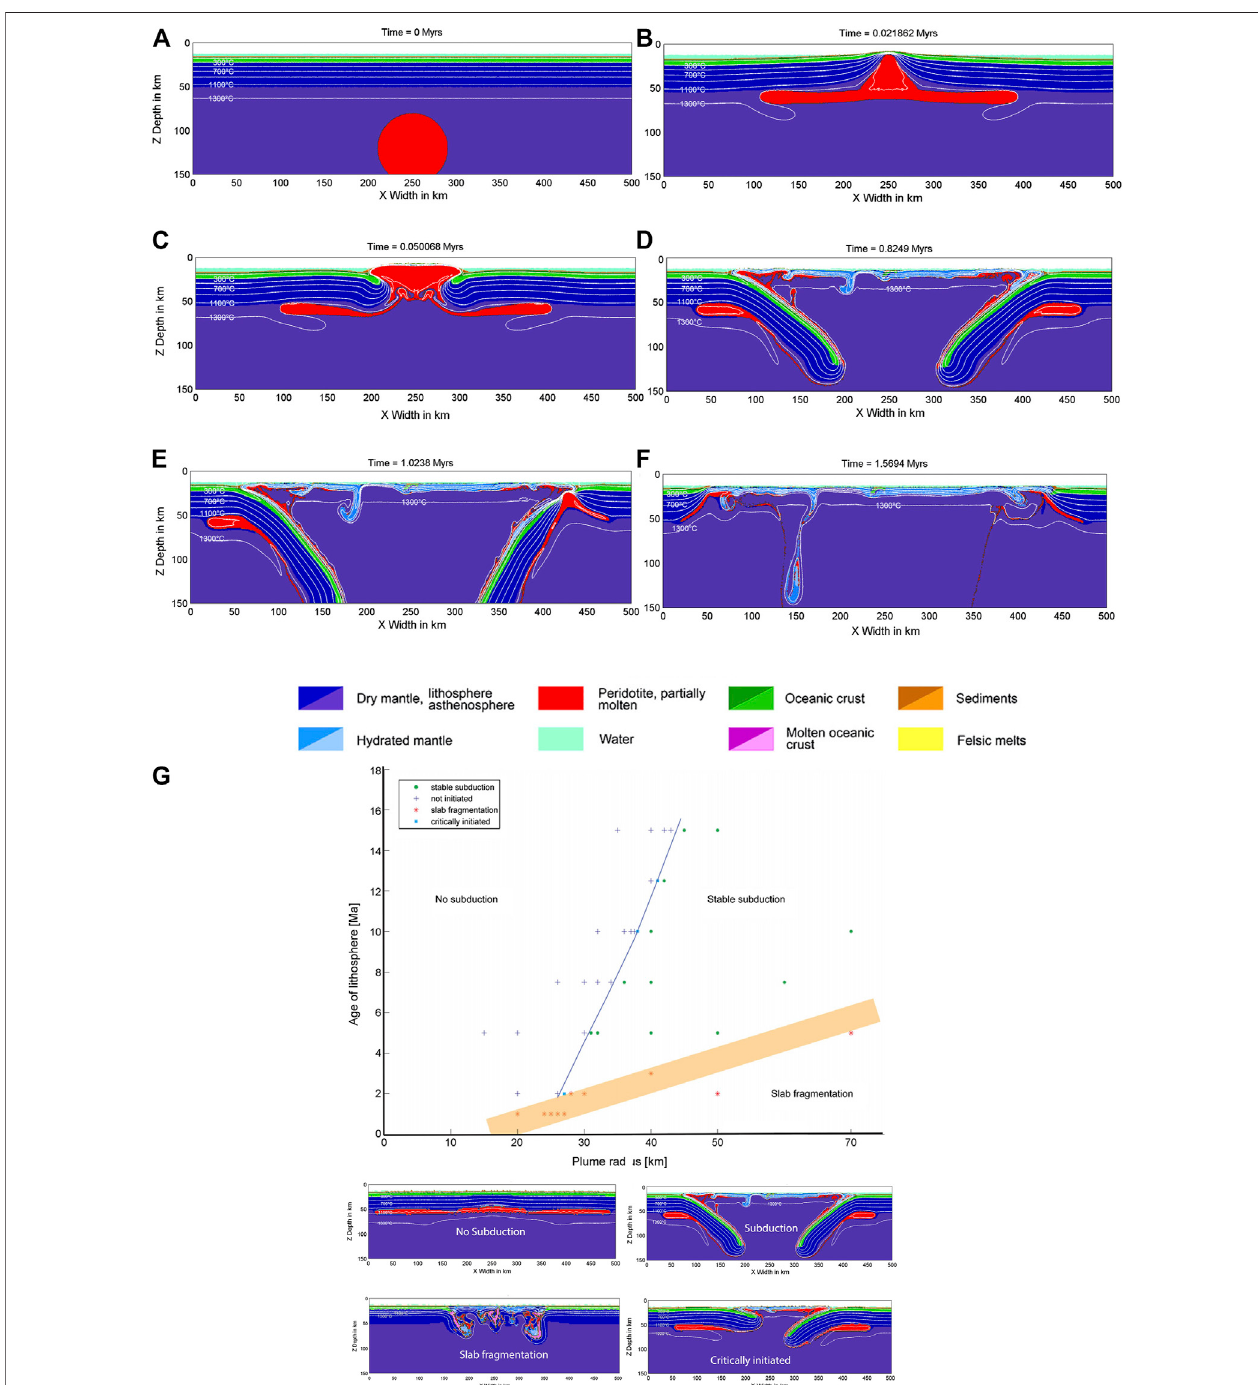
FIGURE3|(A – F) ModelsetupandresultsofUedaetal.(2008). (A) Initialsetup, (B) Risingplumeheadspreadsatthebaseofthelithosphereandapartiallymolten plume passes through the lithosphere, (C) Plume material starts to spread atop the lithosphere, (D) Subduction initiates and continues to be self-sustaining and retreating, (E) The shallow slab breaks off, and (F) New ocean fl oor forms above the plume. (G) Model results summary of Ueda et al., 2008. Lower panels in (G) show one example of each of the different deformation regimes (modi fi ed from Ueda et al., 2008).